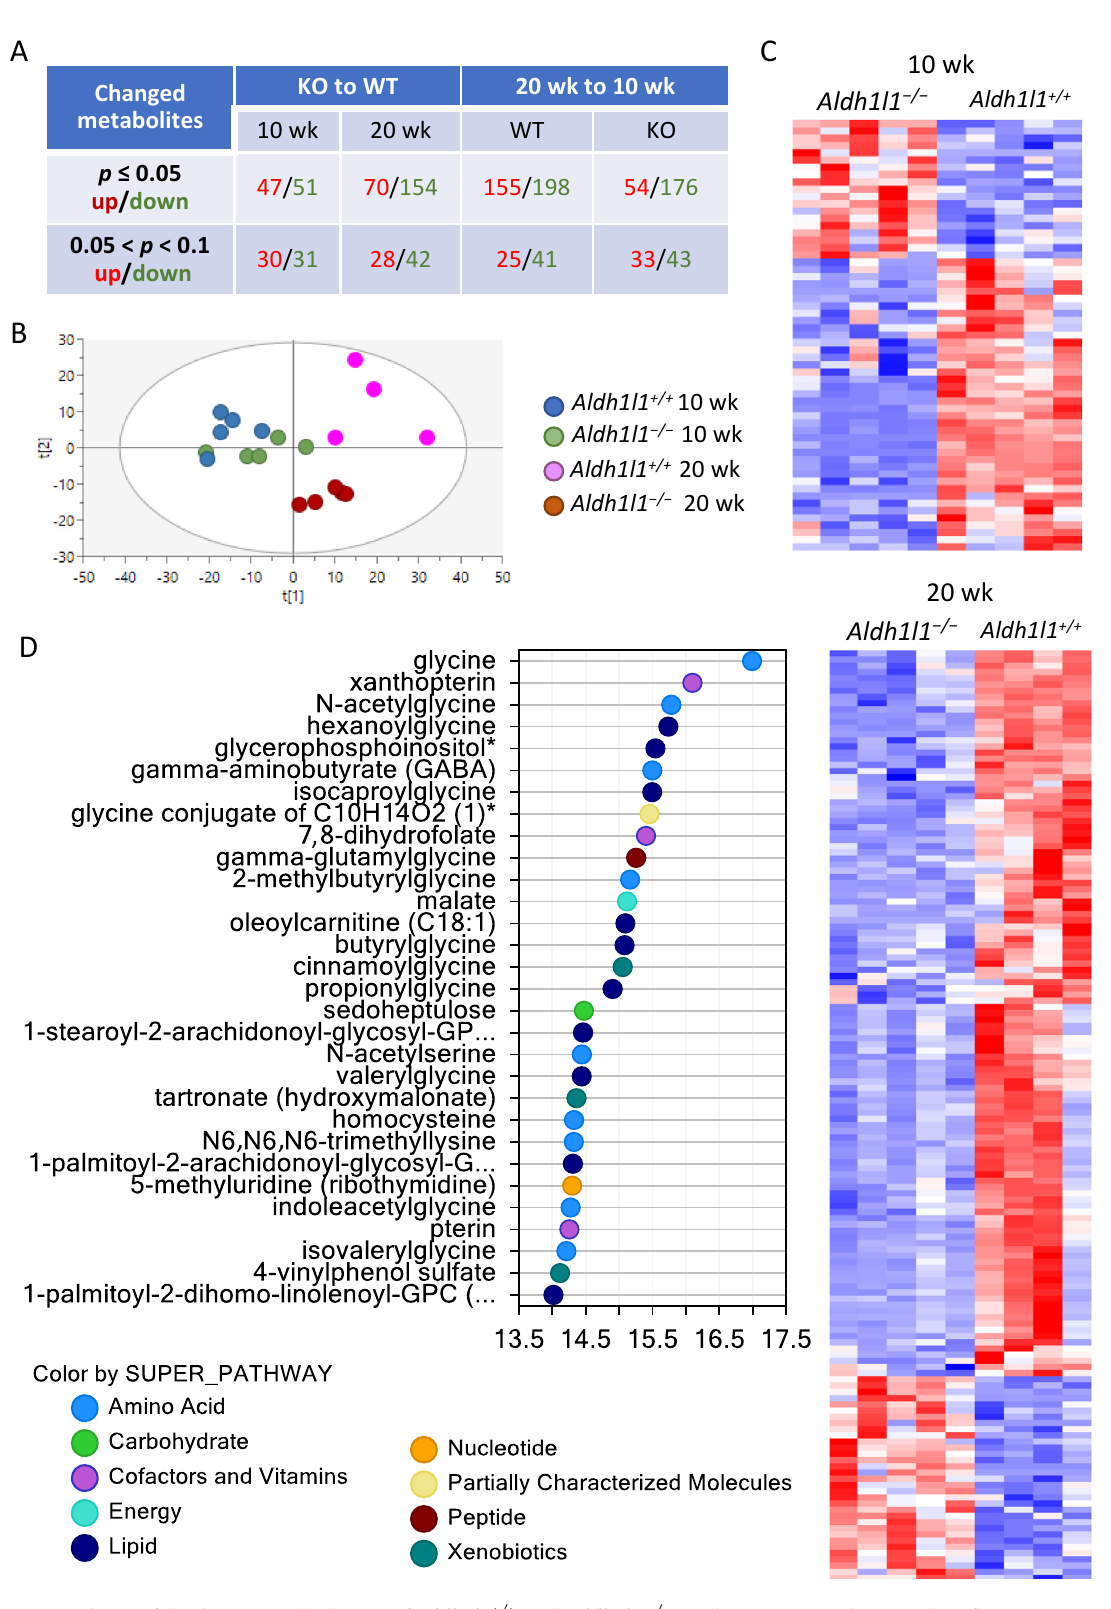
Figure 4. Analysis of the liver metabolomes of Aldh1l1 +/+ and Aldh1l1 − / − male mice 10 and 20 weeks after DEN injection. ( A ) Summary of metabolome analysis. ( B ) PCA visualization of metabolomic profiles. ( C ) Heatmap representation of the metabolite comparison between Aldh1l1 +/+ and Aldh1l1 − / − male mice 10 and 20 weeks after DEN injection (performed with Qlucore Omics Explorer v.3.4 software, Qlucore, Lund, Sweden; data were filtered by p -value ≤ 0.05). ( D ) Biochemical importance plot (Random Forest Analysis).